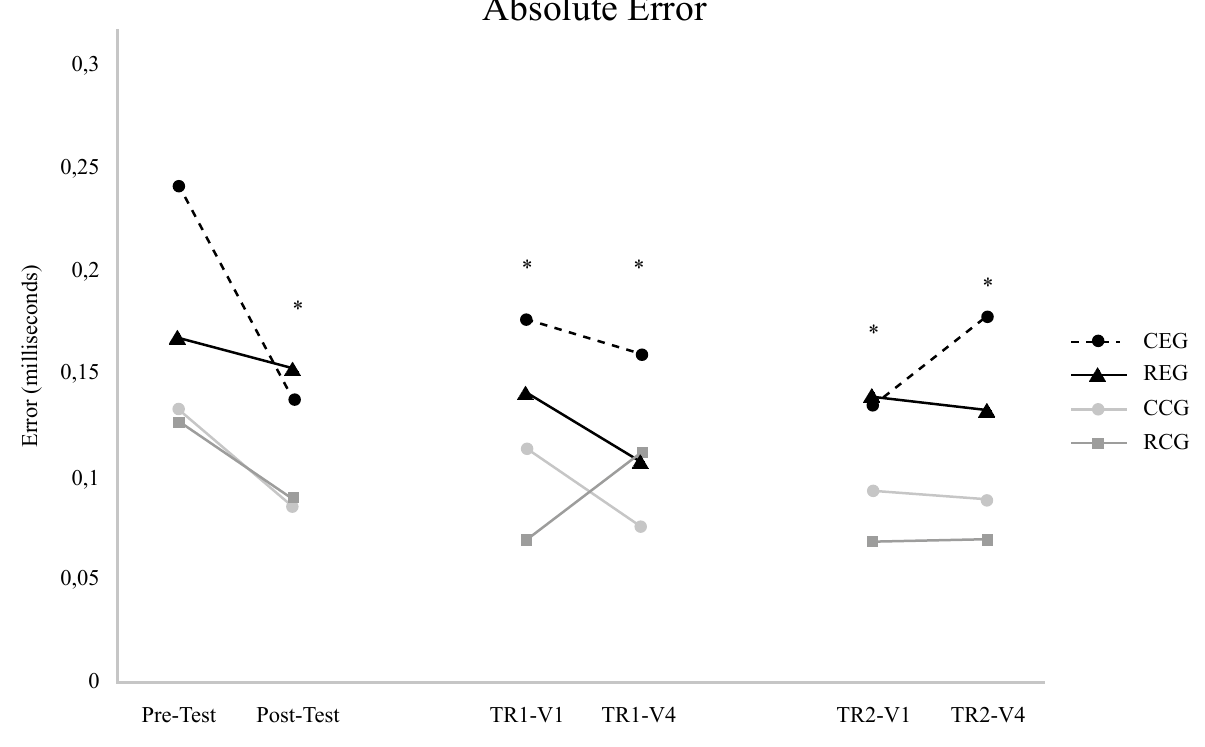
Figure 2= Mean of the constant error along blocks of trials for all groups. Legend: CEG – Constant Experimental Group, REG – Random Experi - mental Group, CCG – Constant Control Group, RCG – Random Control Group, TR1 – Immediate Transfer Test, TR2 – Long Term Transfer